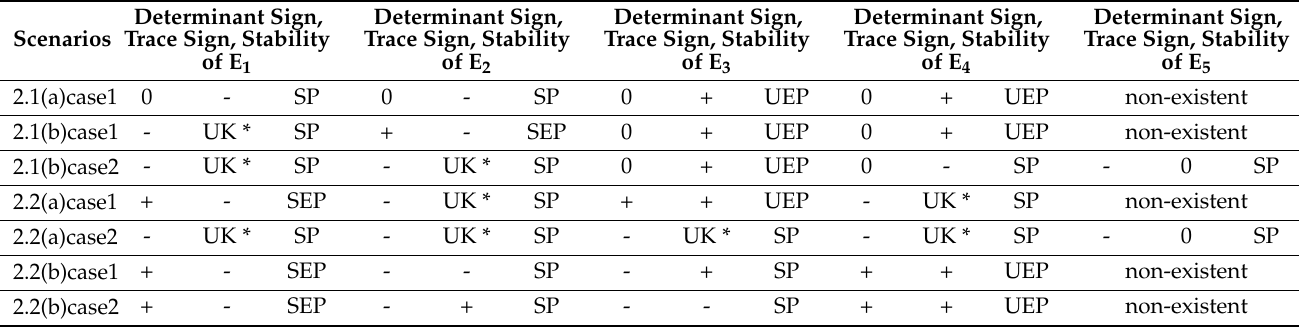
Table 4. Local equilibrium point stability analysis of scenario 2.